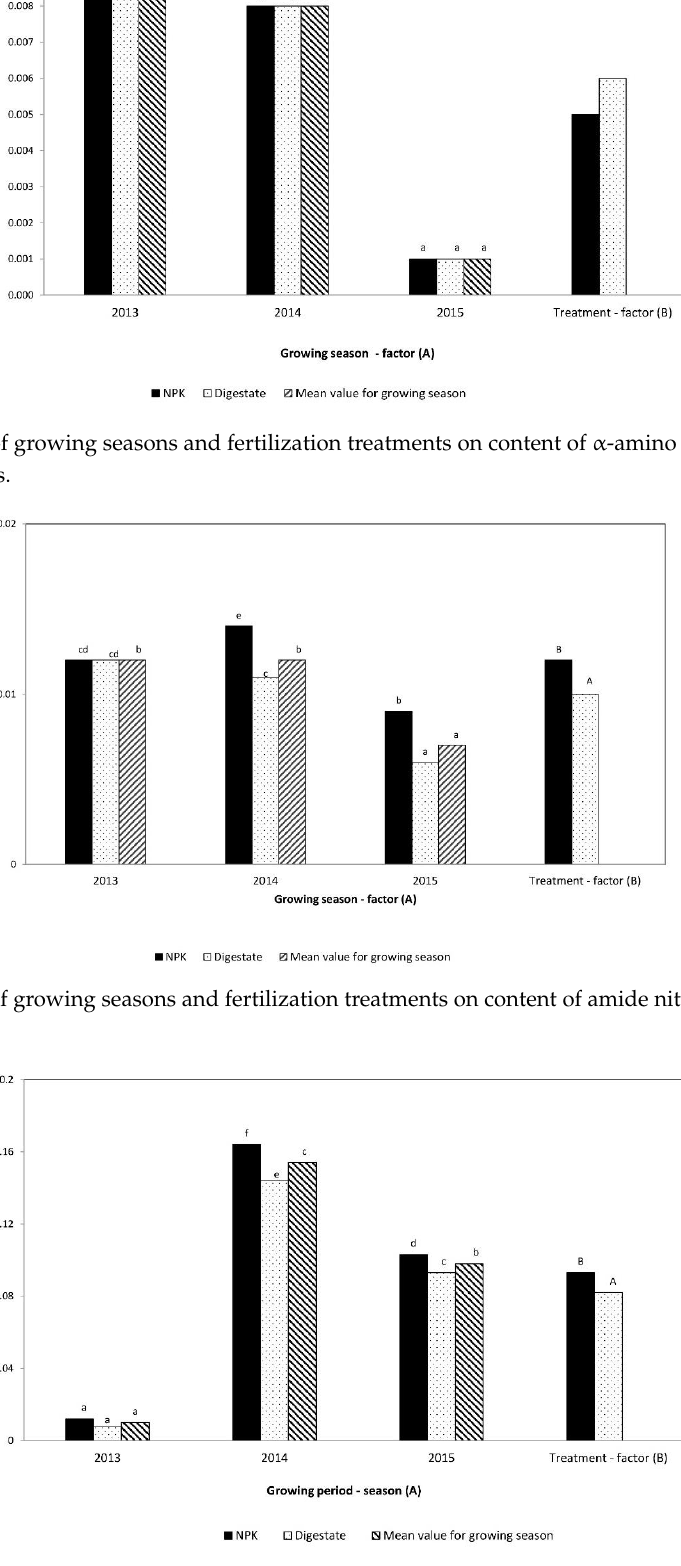
Figure 11. Effects of growing seasons and fertilization treatments on potassium content in sugar beet roots. Sum of both studied elements (sodium and potassium) represents so called “natural alkalinity”. Sugar beet uses them to maintain pH value of juice between 5.8 and 6.2 what favours accumulation of high amount of sucrose. Sodium and potassium in ash represented a dominant fraction. During processing in sugar factory both elements play essential role in maintaining appropriate pH of extract of processed stock material. On the other hand, mentioned alkali metals compounds show high affinity to sucrose and increase sugar concentration in molasses what may result in higher losses of sucrose [30]. Relatively high variability of sodium content in seasons of studies was found because it ranged from 0.012 to 0.164% in 2013 and 2014, respectively. In two seasons (2014 and 2015) as well as on an